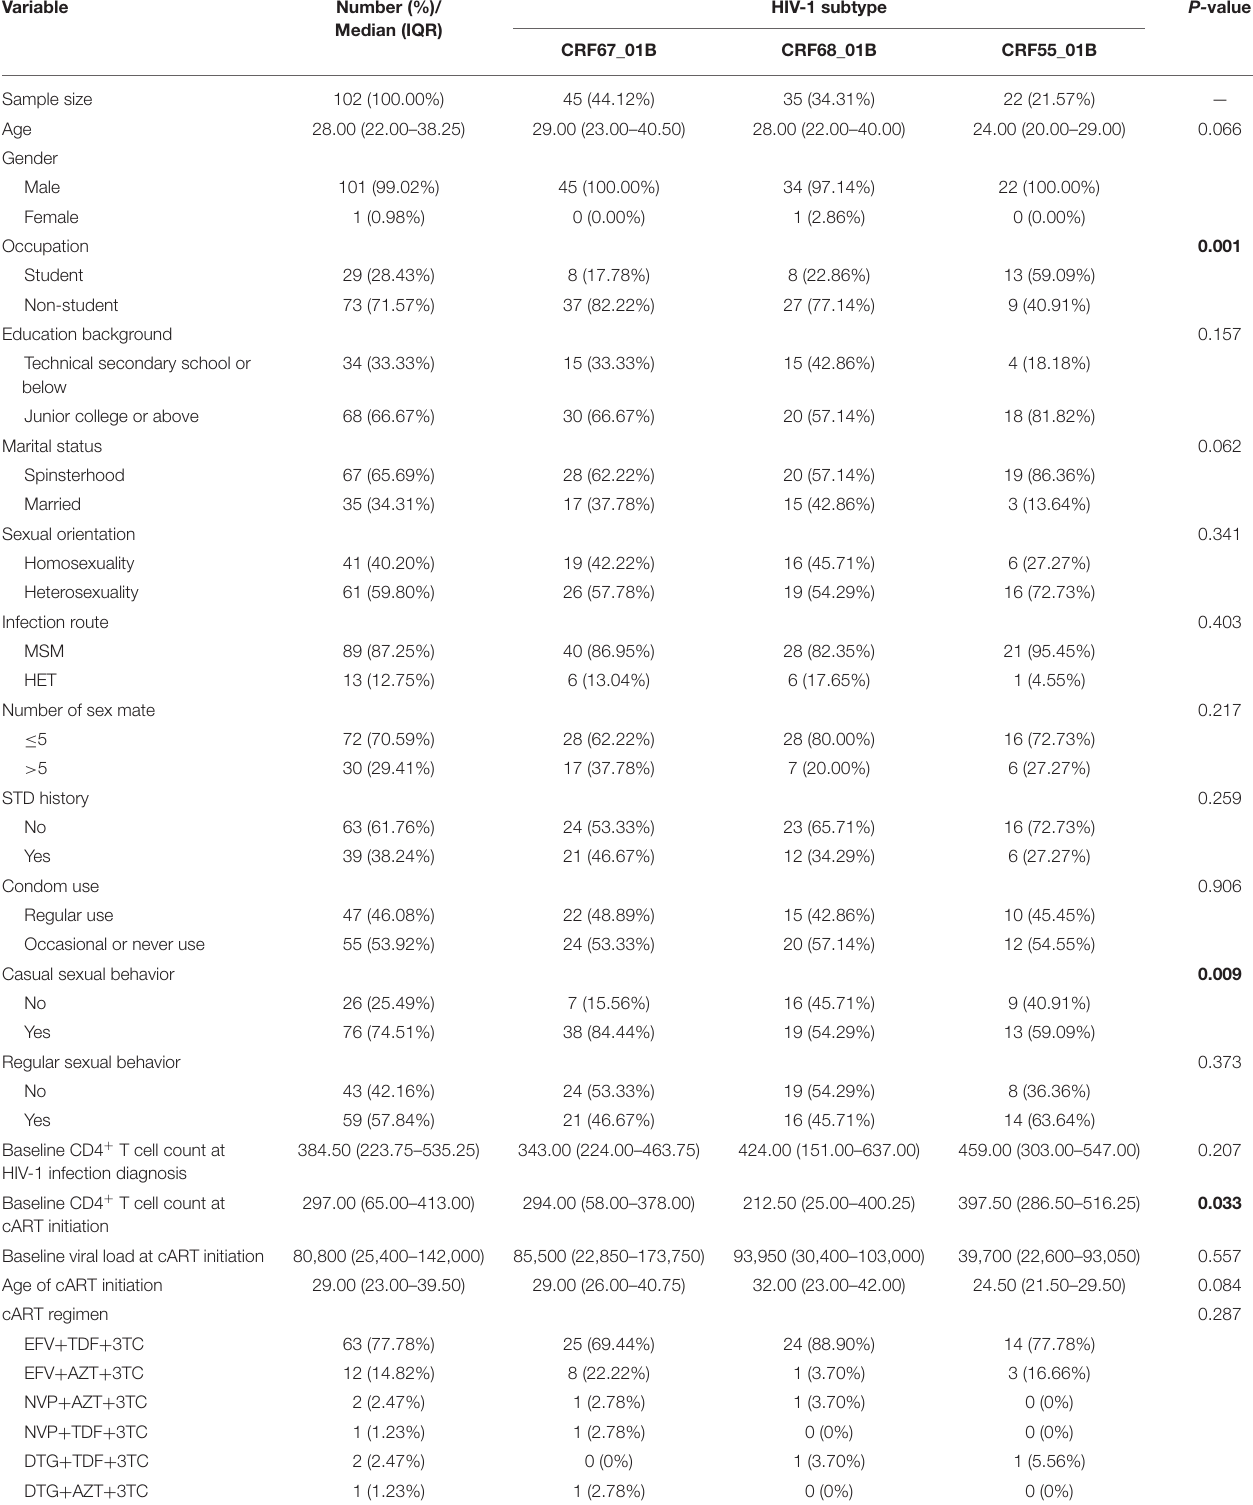
TABLE 1 | Demographic and clinical characteristics among three CRF01_AE/B